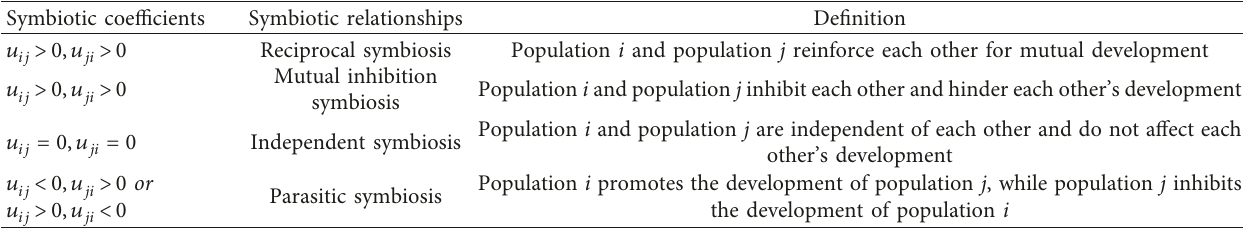
Table 1: Symbiotic